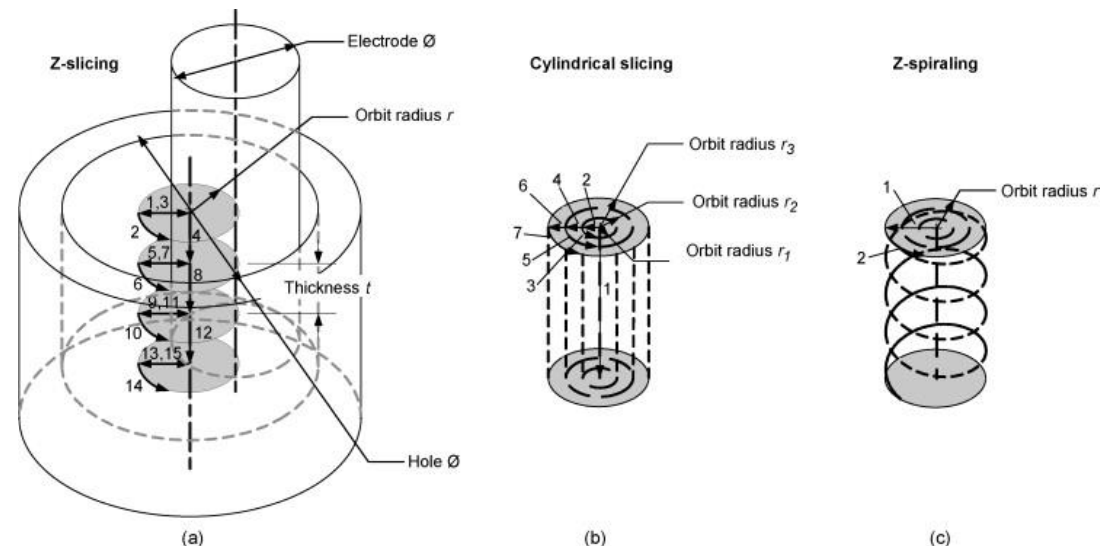
Figure 19. Electrode orbiting strategies: ( a ) slicing the hole into cylinders of thickness t and radius r ; ( b ) slicing the hole into cylindrical shells of radius r ; and ( c ) spiralling into the hole with radius r [182].